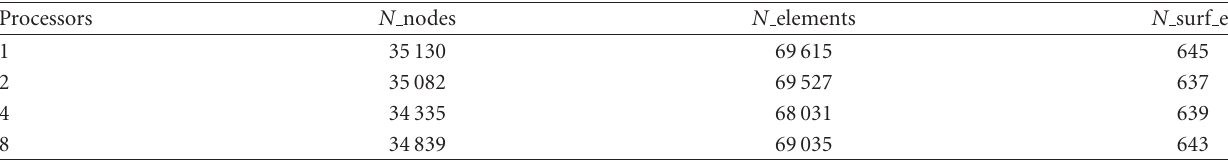
Table 1: Final grid sizes for di ff erent number of processors after 4 adaptation steps. 2D NACA 0012 airfoil.